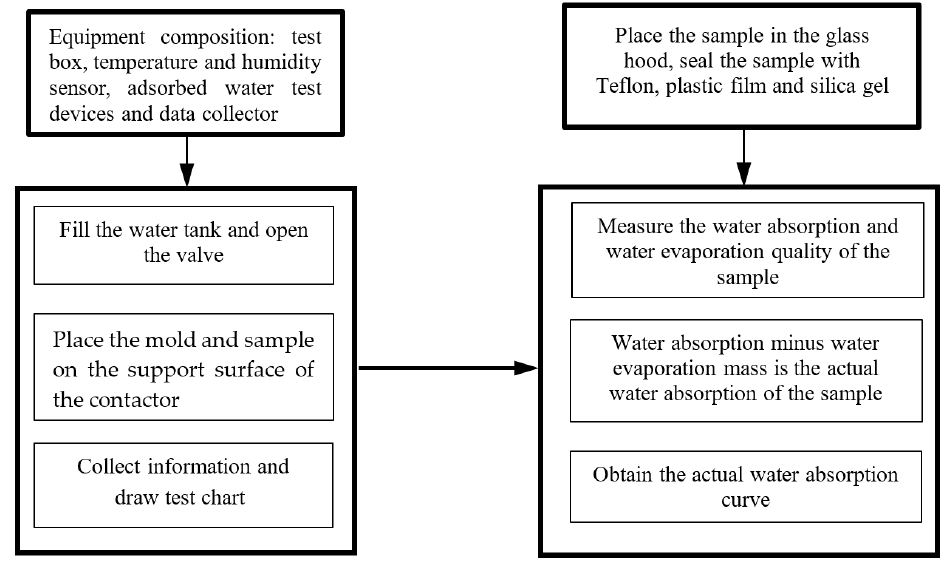
Figure 3. Real-time monitoring experimental procedures for imbibition test without water pressure.